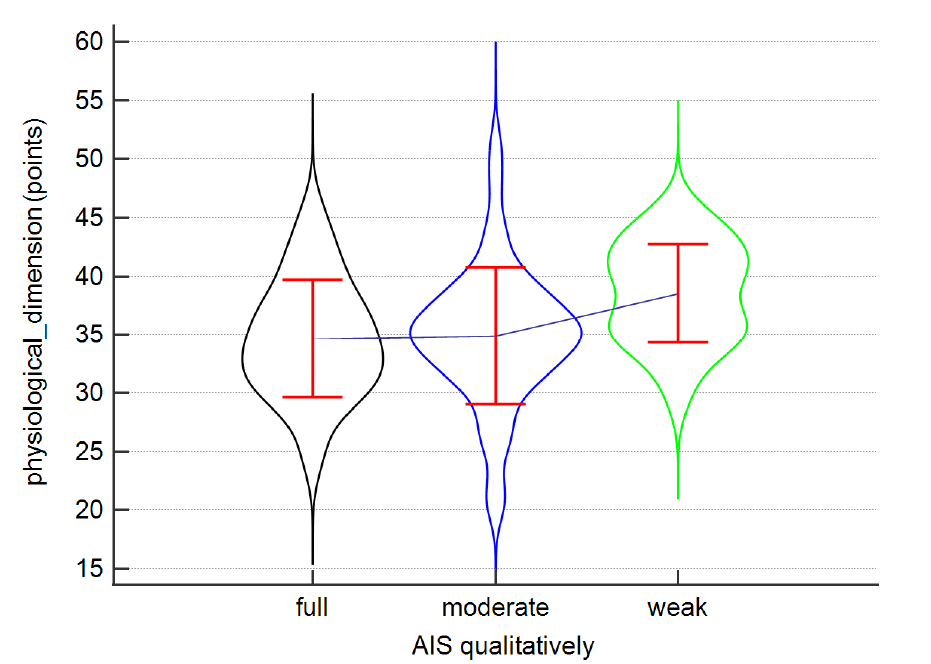
Figure 5. Number of points for the CAPS physiological dimension domain and the level of disease acceptance. Means and standard deviations are given.